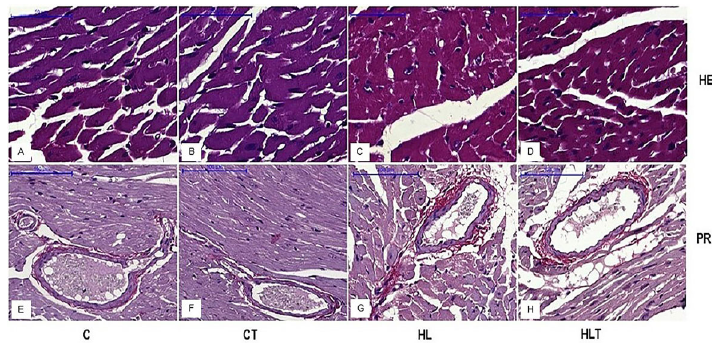
Figure 1. A – D , Photomicrographs of the left ventricle, showing the diameter of the cardiomyocytes, stained with hematoxylin and eosin (HE). E – H , Photomicrographs showing the distribution of interstitial and perivascular staining with red collagen (marked red by the dye) in the left ventricular myocardium of picrosirius (PR) stained mice. Groups: C, standard diet; CT, standard diet with tri-tea; LH, high-fat diet; HLT, high-fat diet with tri-tea. Scale bar: 100 m